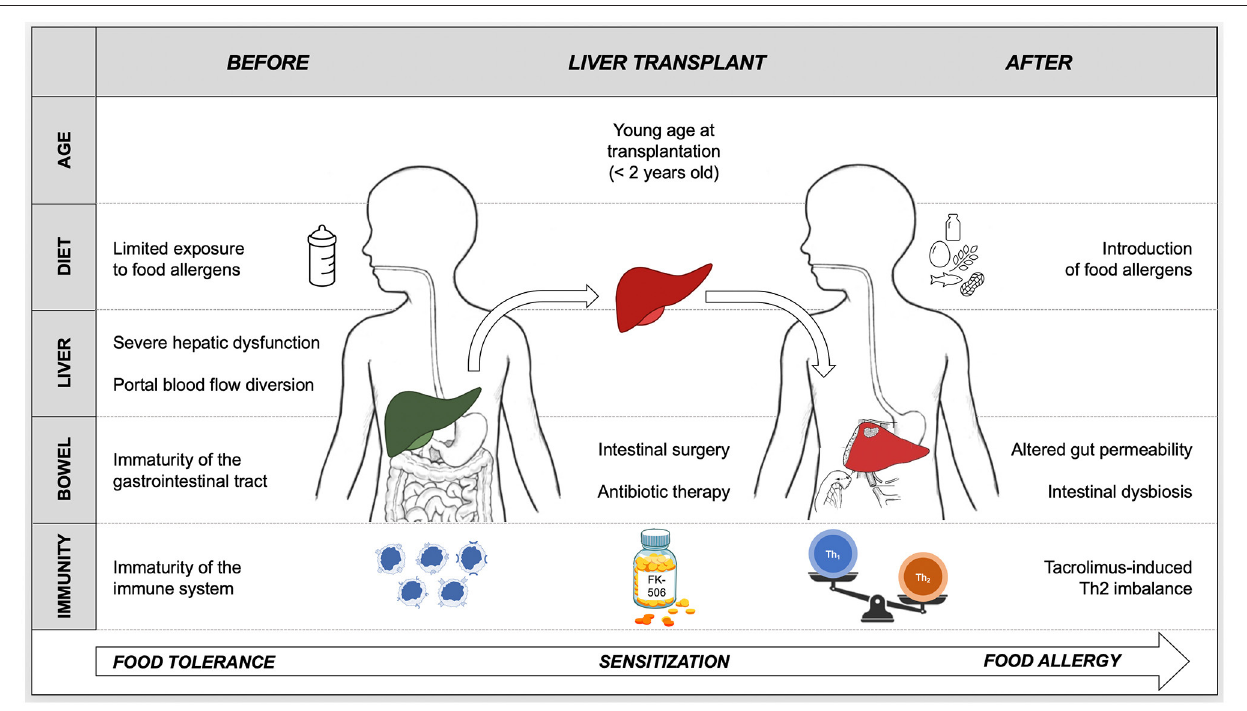
FIGURE 2 | Proposed pathogenesis of de novo food allergy in pediatric liver transplant recipients based on current available knowledge. Oral tolerance is the physiologic response to food allergens that takes place during infancy and continues throughout life. A breakdown in this process results in the sensitization to food antigens and in the progression to food allergy. Several factors concur in determining the loss of tolerance to food allergens and in triggering the onset of allergy after pediatric liver transplantation. Tacrolimus-based immunosuppression plays a role in food sensitization by inducing an immunological imbalance toward Th2 responses. The likelihood of developing food allergy is inversely proportional to the age at liver transplantation, hence young age must facilitate the breakdown of oral tolerance. The immaturity of the immune system and of the gastrointestinal tract, combined with the liver dysfunction, the diversion of portal blood flow into the systemic circulation and with the delayed introduction of solid allergenic foods before transplant, hamper oral tolerance acquisition. The disruption of the intestinal barrier with consequent increased gut permeability, induced by surgery, antibiotic-induced dysbiosis and drugs (e.g., tacrolimus), causes a massive exposure of food allergens to an “imbalanced” immune